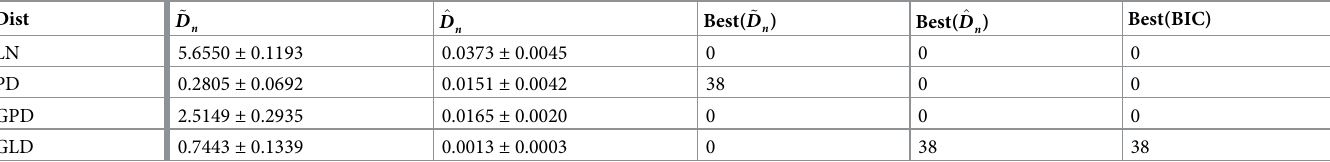
Table 5. Comparisons of goodness-of-fit to firm size data.